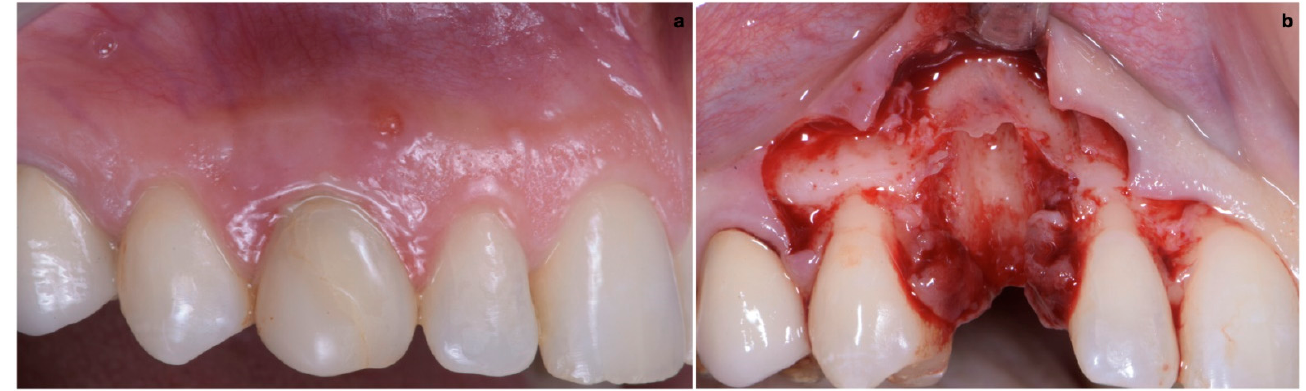
Figure 4. ( a , b ) Lateral-approach coronally advanced envelope flap, with oblique submarginal interproximal incisions directed towards the flap’s center of rotation (the tooth to be extracted).